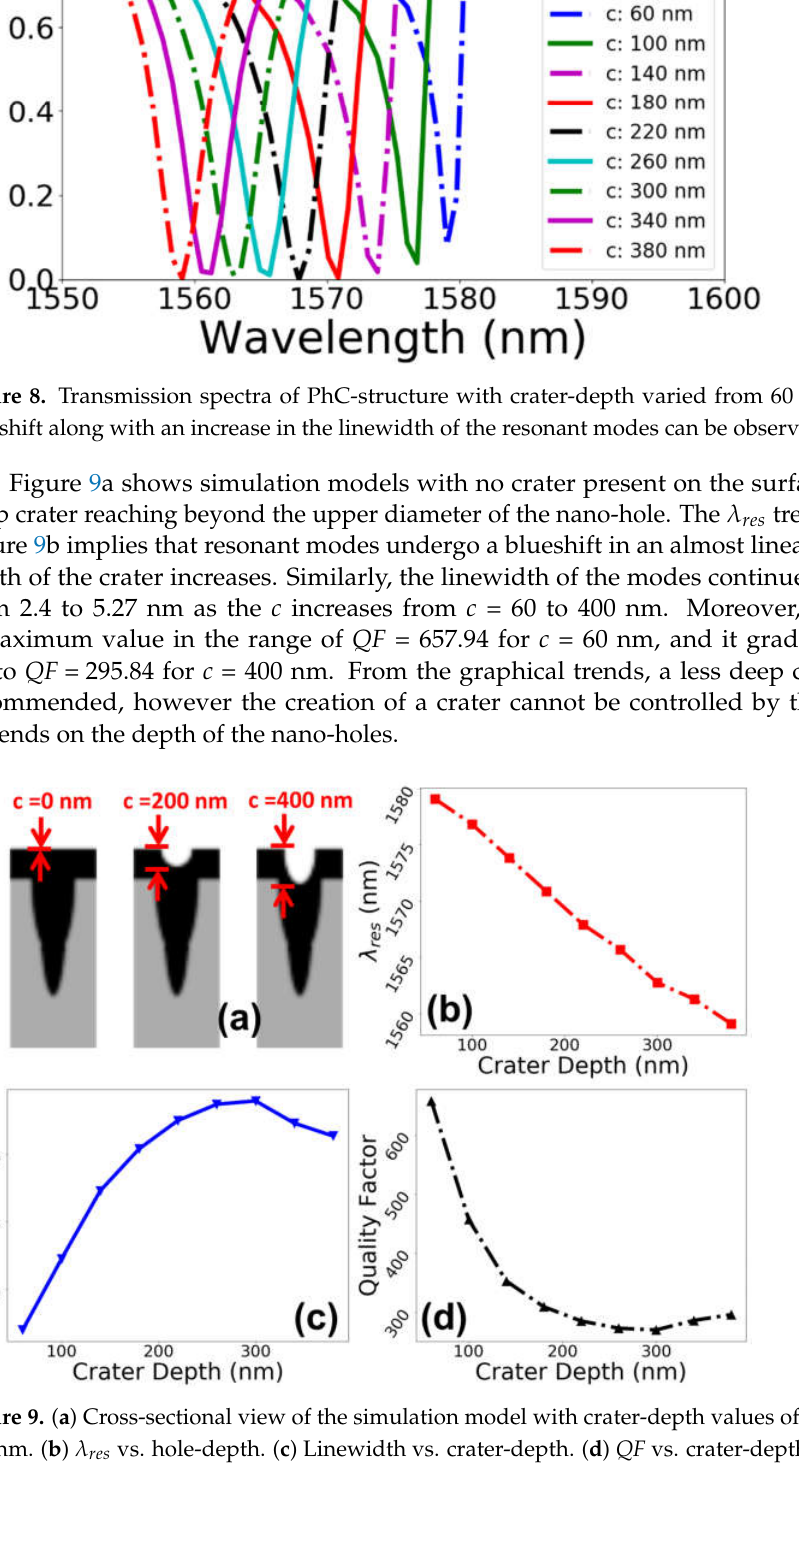
Figure 9. ( a ) Cross-sectional view of the simulation model with crater-depth values of c = 0, 200 and 400 nm. ( b ) λ res vs. hole-depth. ( c ) Linewidth vs. crater-depth. ( d ) QF vs.